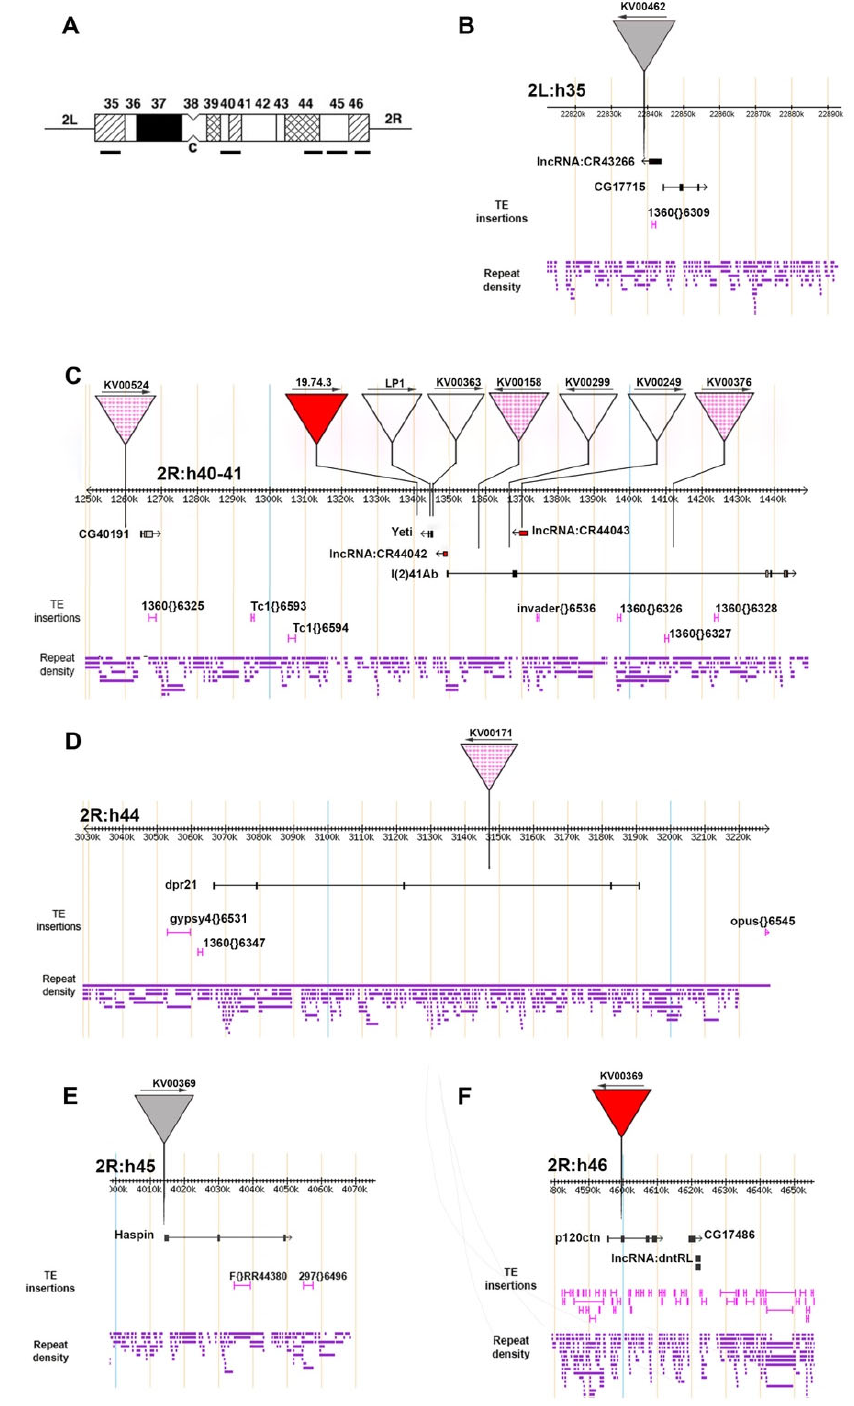
Figure 6. Genomic localization of the Pw + reporters under investigation. ( A ) Cytogenetic map of the heterochromatin of chromosome 2 showing the location of the genomic regions analyzed in this work. From left to right: 2L:h35, 2R:h40 ‐ 41, 2R: h44, 2R:h45 ‐ 46, 2R:h46. The genomic regions in ( B – F ) show the localization of the Pw + reporter insertions relative to genes and the distribution of TEs and repetitive sequences. Red triangle = fully suppressed Pw + reporter; dashed triangle = Pw + reporter suppressed only in some cases; white triangle = Pw + reporter insensitive to suppression; grey triangle = Pw + reporter not tested for suppression.